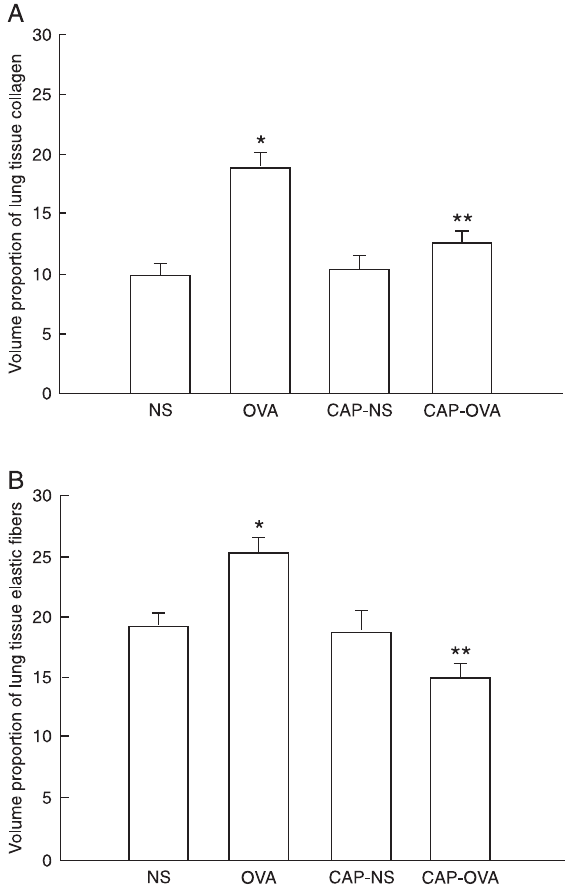
Figure 6. Lung parenchyma remodeling. The content of collagen (A) and elastic fibers (B) in lung tissue (alveolar septa) of guinea pigs (means and SEM) submitted to seven inhalations of oval- bumin (OVA) or normal saline (NS) are represented. Results are reported as percentage. *P < 0.05 compared with NS-exposed guinea pigs; **P < 0.01 compared with OVA-exposed animals that received vehicle of capsaicin (OVA x CAP-OVA groups). Sta - tistical analysis was done by two-way analysis of variance and multiple comparisons were made using the Holm-Sidak method.